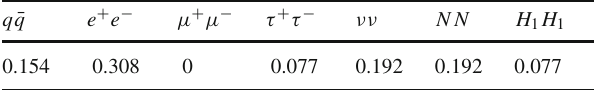
→ N ) is less than 0.01, thus is not shown in the 1 1 N 1